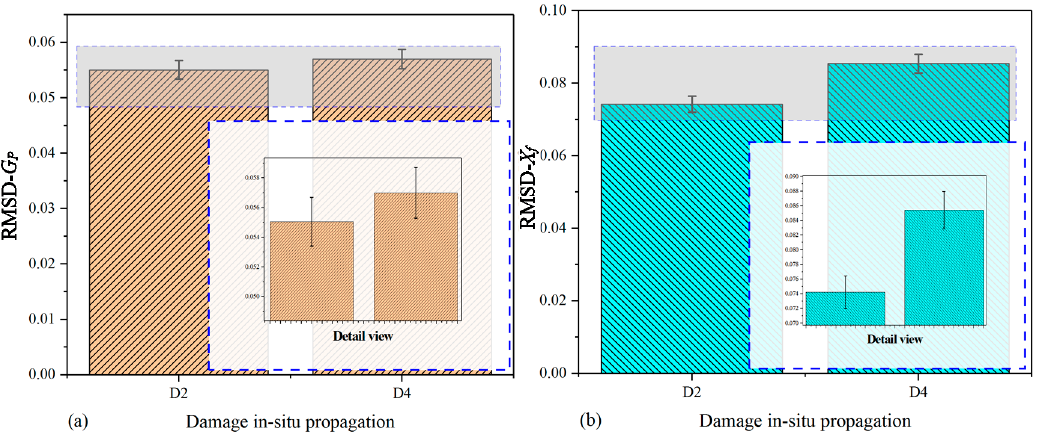
Figure 7. RMSD calculated based on real part of signatures for specimen-1: ( a ) raw conductance signatures G P , ( b ) extracted DCMI signatures X f .